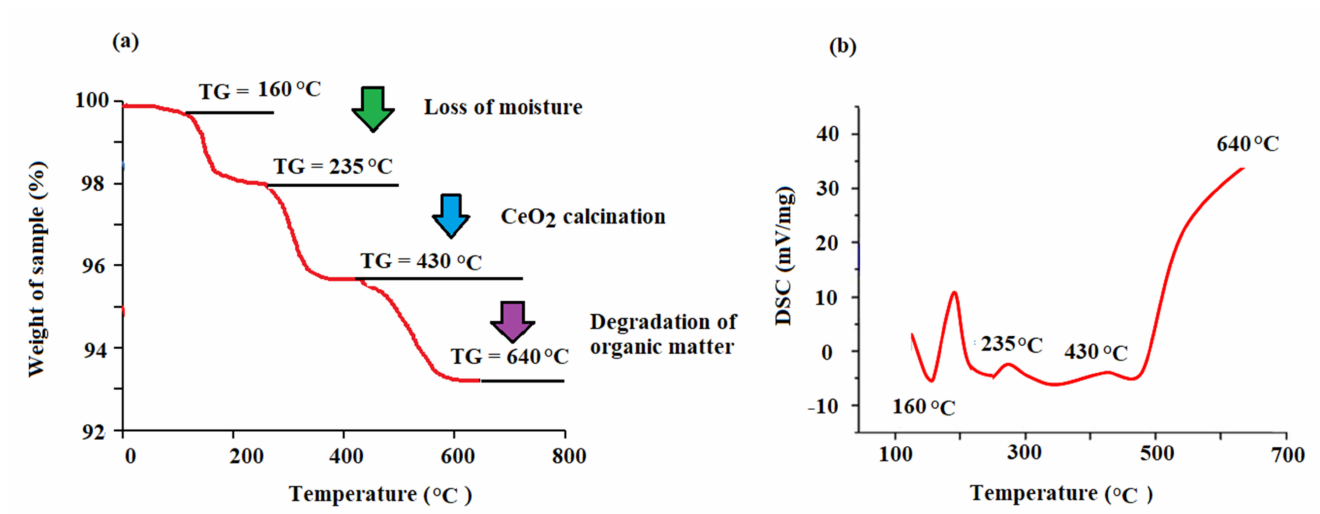
Figure 6. ( a ) Thermogravimetric (TGA) and ( b ) diffraction scanning calorimetry (DSC) of the biogenic CeO 2